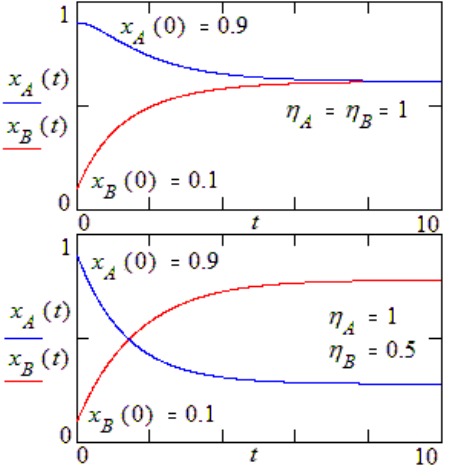
Figur e 2: Dynamics of the mean-field model in the monomer